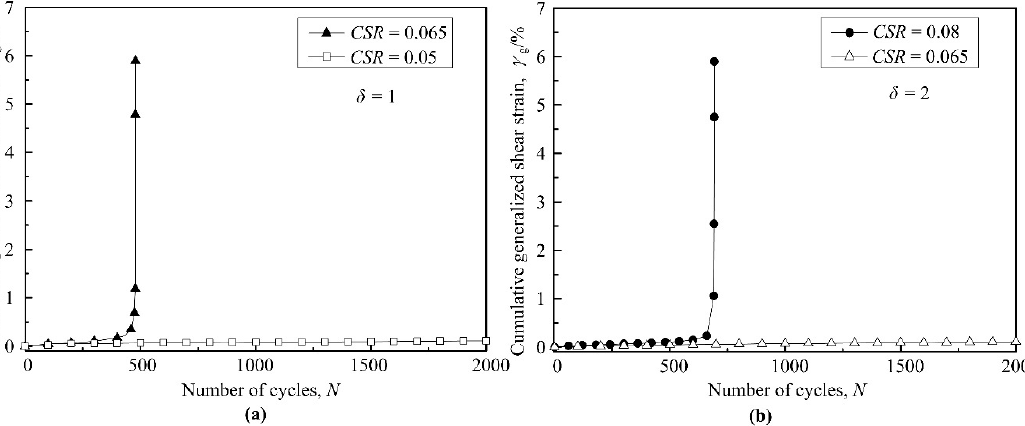
Figure 8. ( a , b ) Relationship between cumulative generalized shear strain and number of cycles under different stress paths.